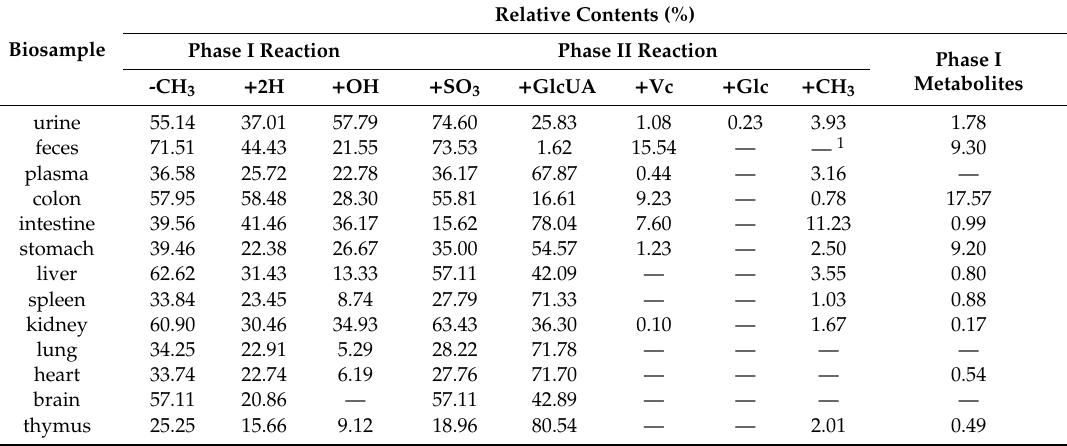
Table 1. Relative contents of metabolic reactions and phase I metabolites of medicarpin in 13 biological samples